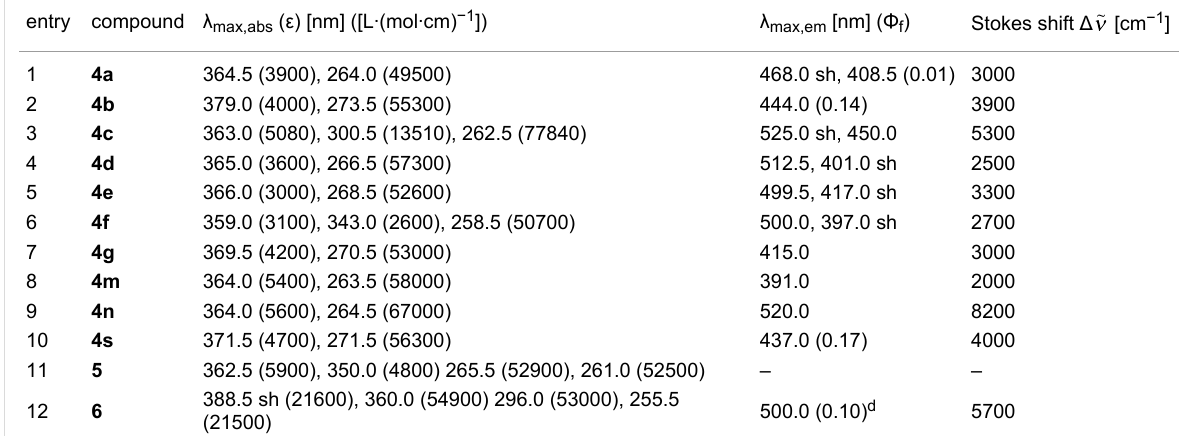
Table 6: Selected photophysical properties (absorption and emission maxima, a,b fluorescence quantum yields ( Φ f [53]), c and Stokes shifts Δ d ) of compounds 4a–g , m , n , s , 5 , and 6